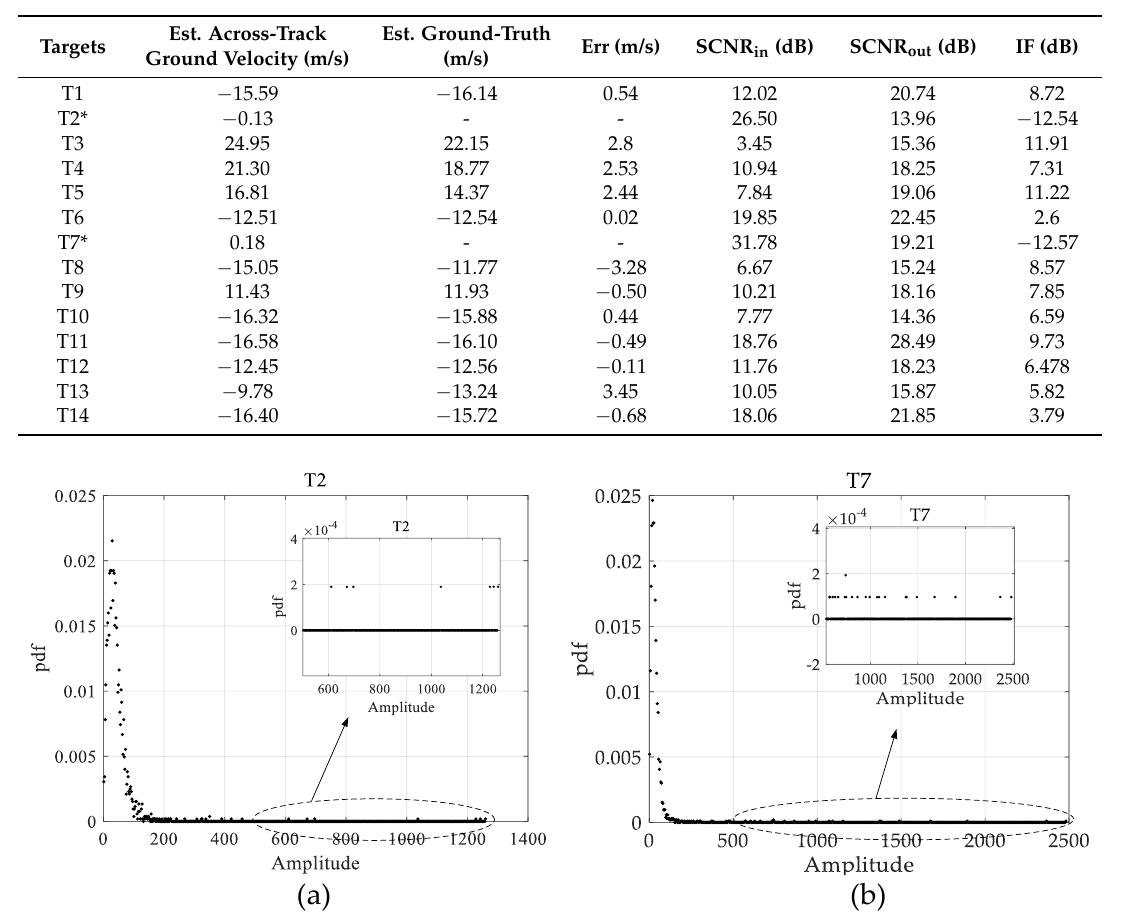
Table 2. Across-track velocity estimation result for detected targets (the clutter cancellation is performed using SSP and the across-track velocity is estimated using AMF; asterisk denotes false detection). Targets